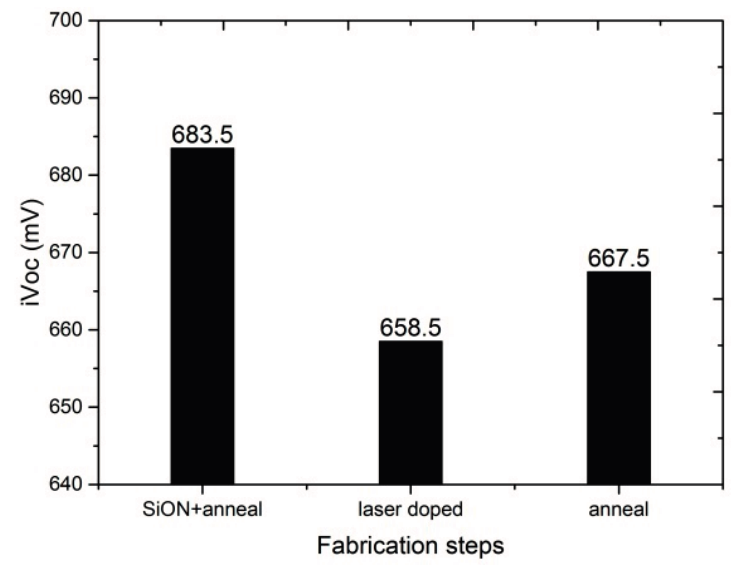
Figure 7. iV oc changes in the laser doping process on a test sample epi layer on FZ